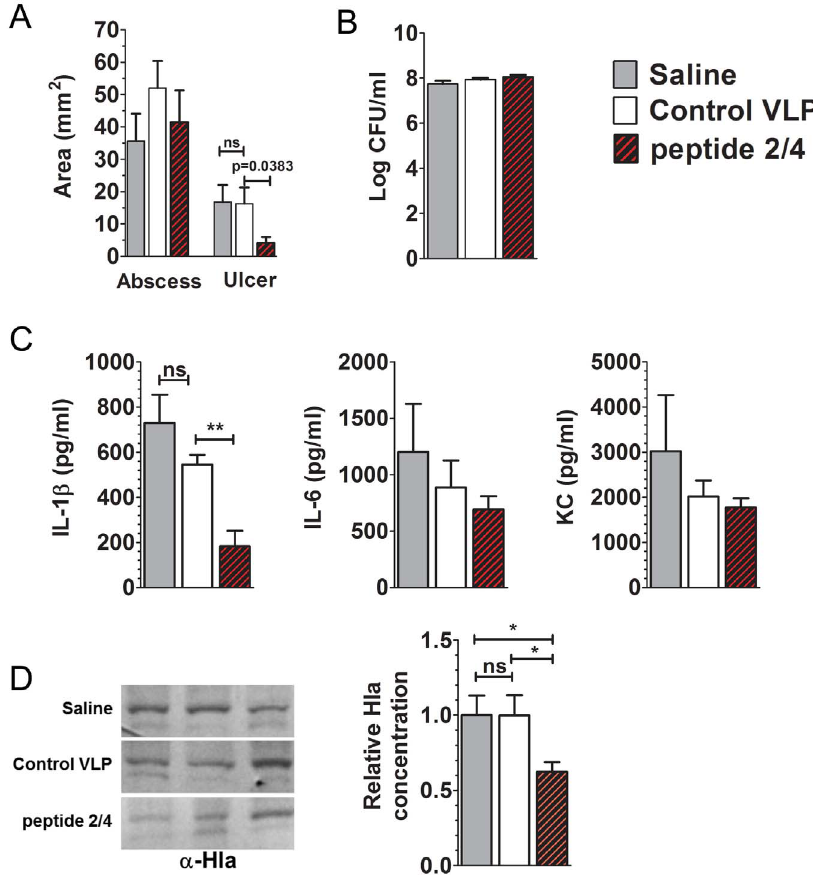
Figure 4. A combination vaccine of two VLP mimotopes limits pathogenesis in a mouse model of S.aureus dermonecrosis. Mice were vaccinated with 10 m g of a 1:1 suspension of peptide 2 and peptide 4 and inoculated with 1 6 10 8 CFU of AH1872 as described previously. At the apex of infection (day 3) (A) abscess and ulcer area were measured and (B) bacterial burden at the site of infection was determined, and (C) local cytokine and chemokine levels were determined. (D) Western blot showing relative HLA levels in tissue homogenate of vaccinated and challenged mice. Quantification based on Western blot band intensity relative to total protein concentration. Data are shown as the mean 6 SEM of 6–10 mice per group. ns, not significant; *, p , 0.05; **, p ,